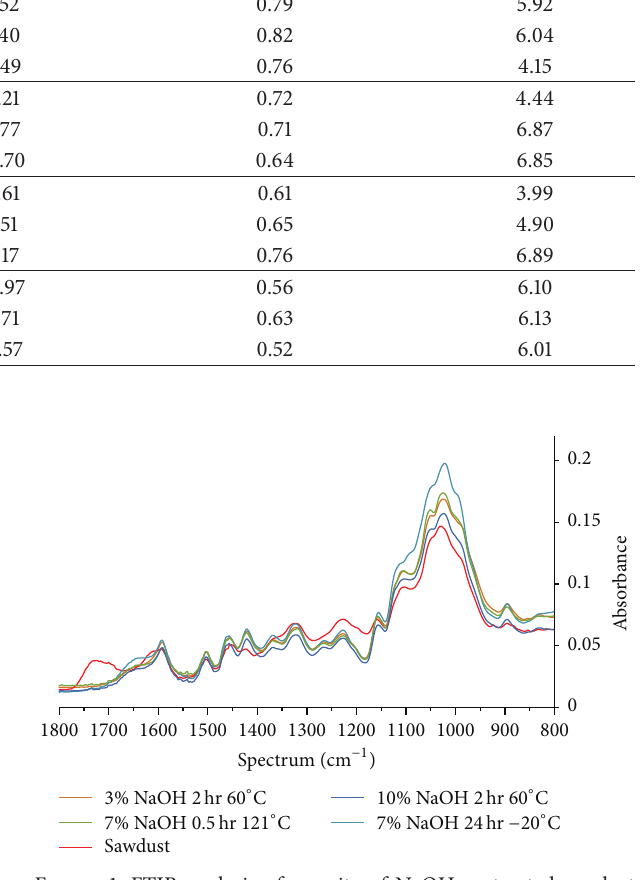
Table 3. The highest glucose yield obtained was 16.2 ±